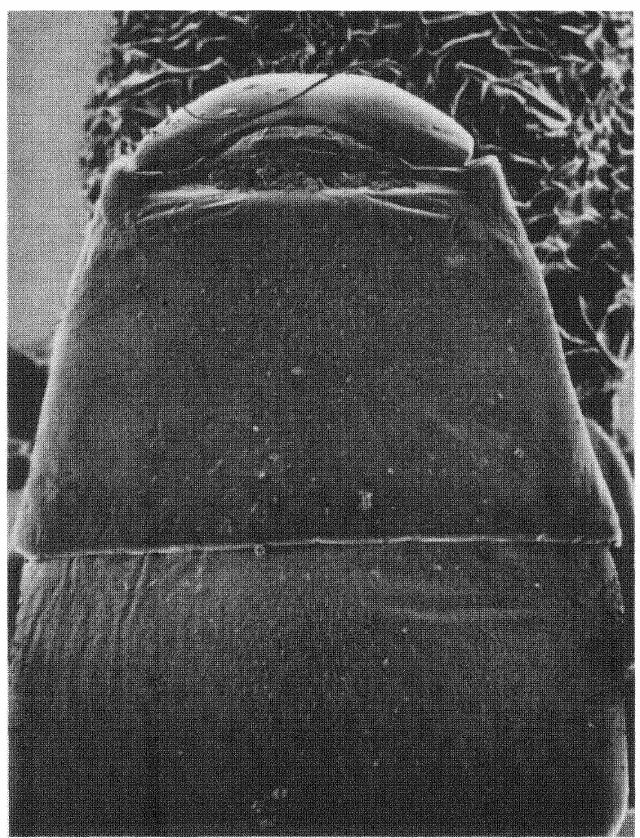
Fig. 7. Cosmiocryptus violaceipennis, of propodeum and much of first 3 gastric tergites in dorsal